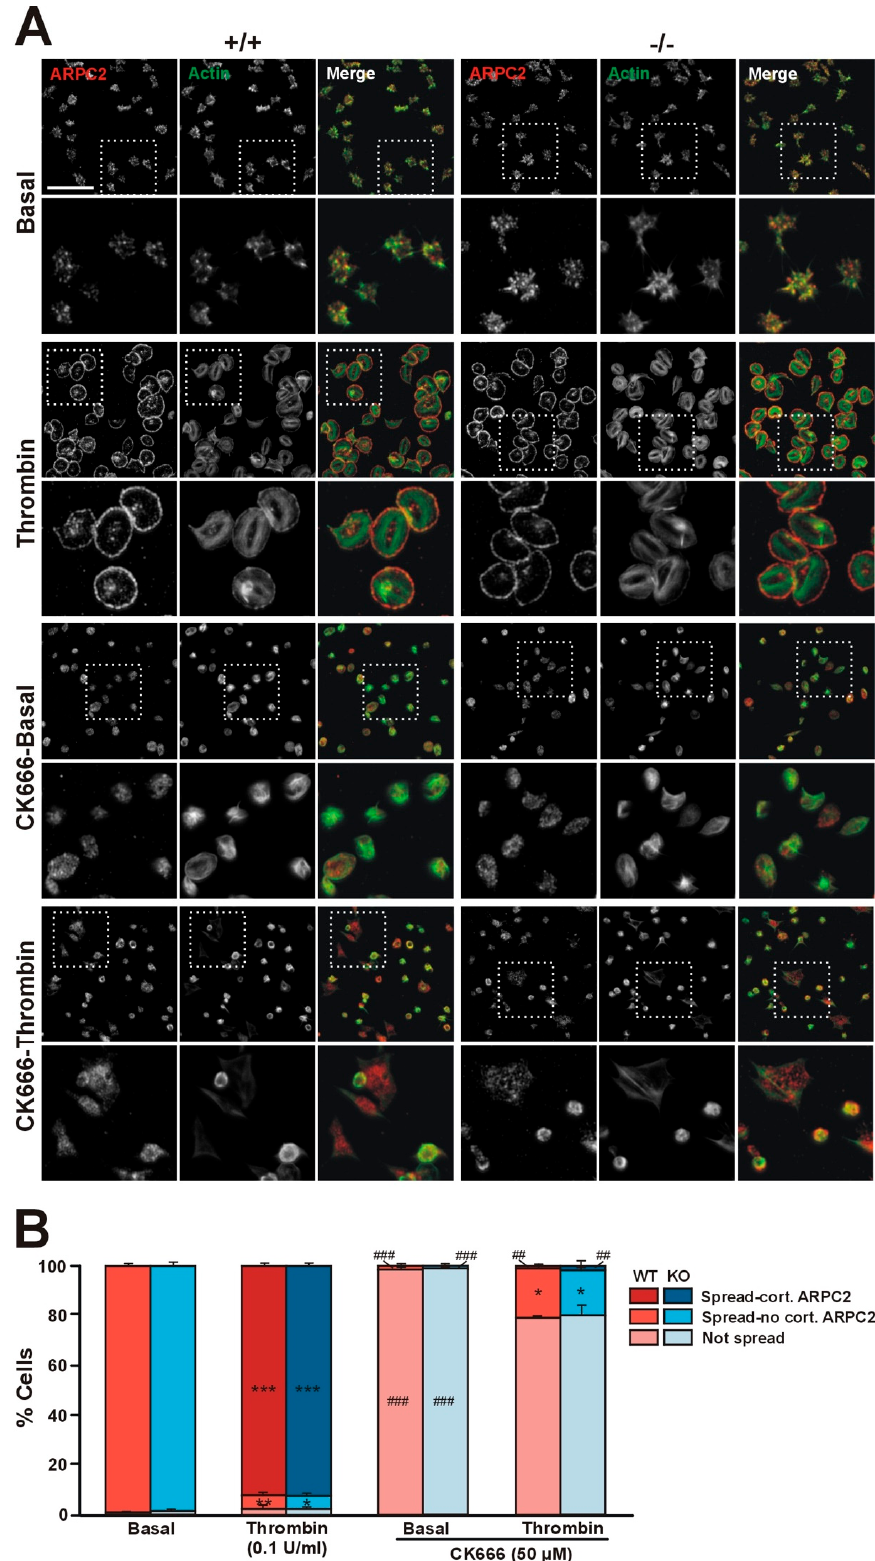
Figure 6. Coro1 is dispensable for Arp2 / 3 complex localization. ( A ) Localization of ARPC2 in resting and thrombin-stimulated platelets. Washed platelets were stimulated with 0.1 U / mL thrombin and immediately allowed to attach to glass coverslips coated with 100 µ g / mL of fibrinogen. A